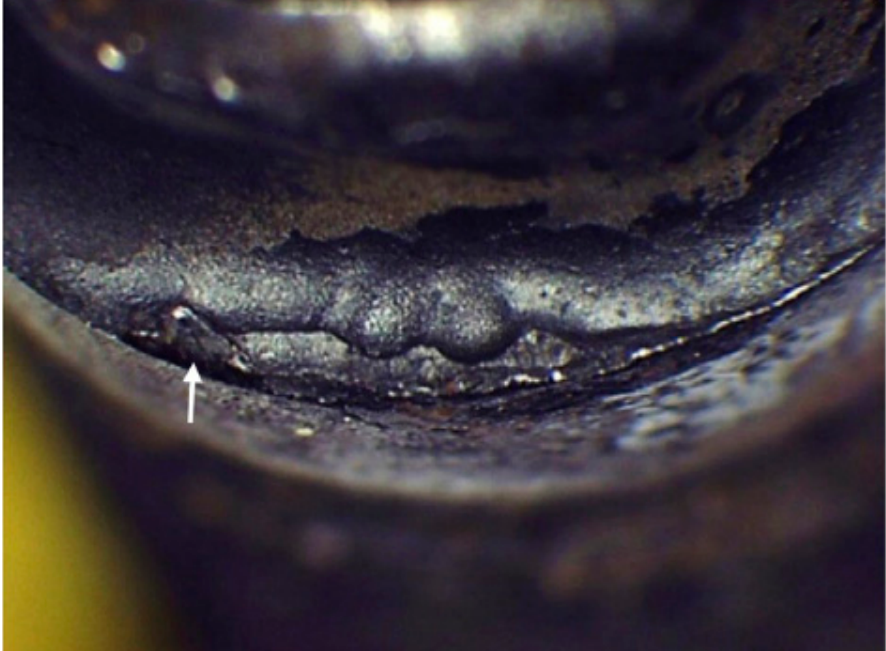
Figure 20. Fracture surface at 30× showing the nucleation zone indicated by the arrow and the propagation zone showing the red rust [162].